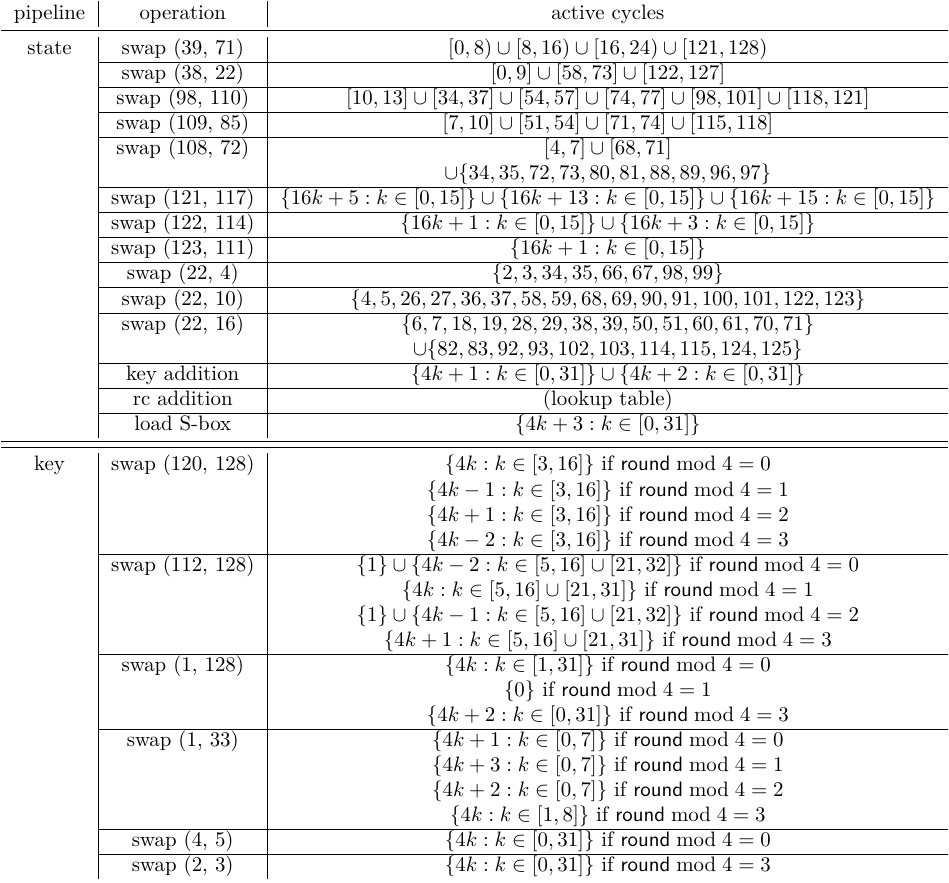
Table 15: The timetable of operations for bit-serial GIFT encryption.